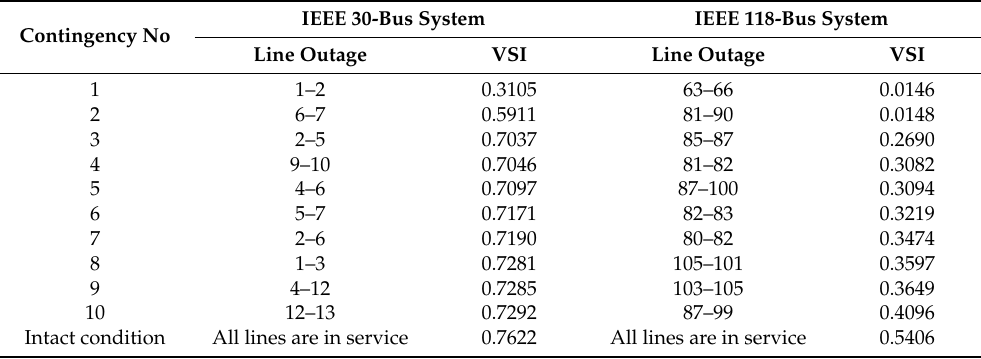
Table 3. Set of the critical contingencies for IEEE 30-bus and 118-bus test